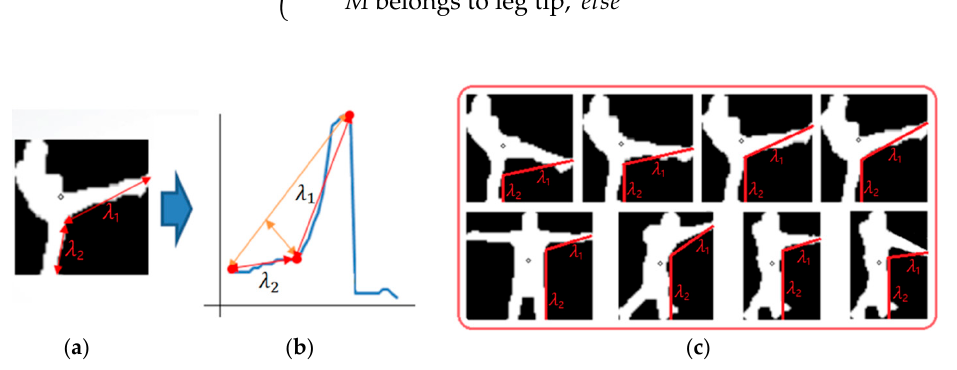
Figure 8. Examples of the two features (cid:2019) (cid:2869) and (cid:2019) (cid:2870) for kicking, and the comparison of these two features for kicking and punching. ( a ) Case of kicking; ( b ) profile graph of (a) by the proposed PbD method; ( c ) comparison of (cid:2019) (cid:2869) and (cid:2019) (cid:2870) for kicking and punching.